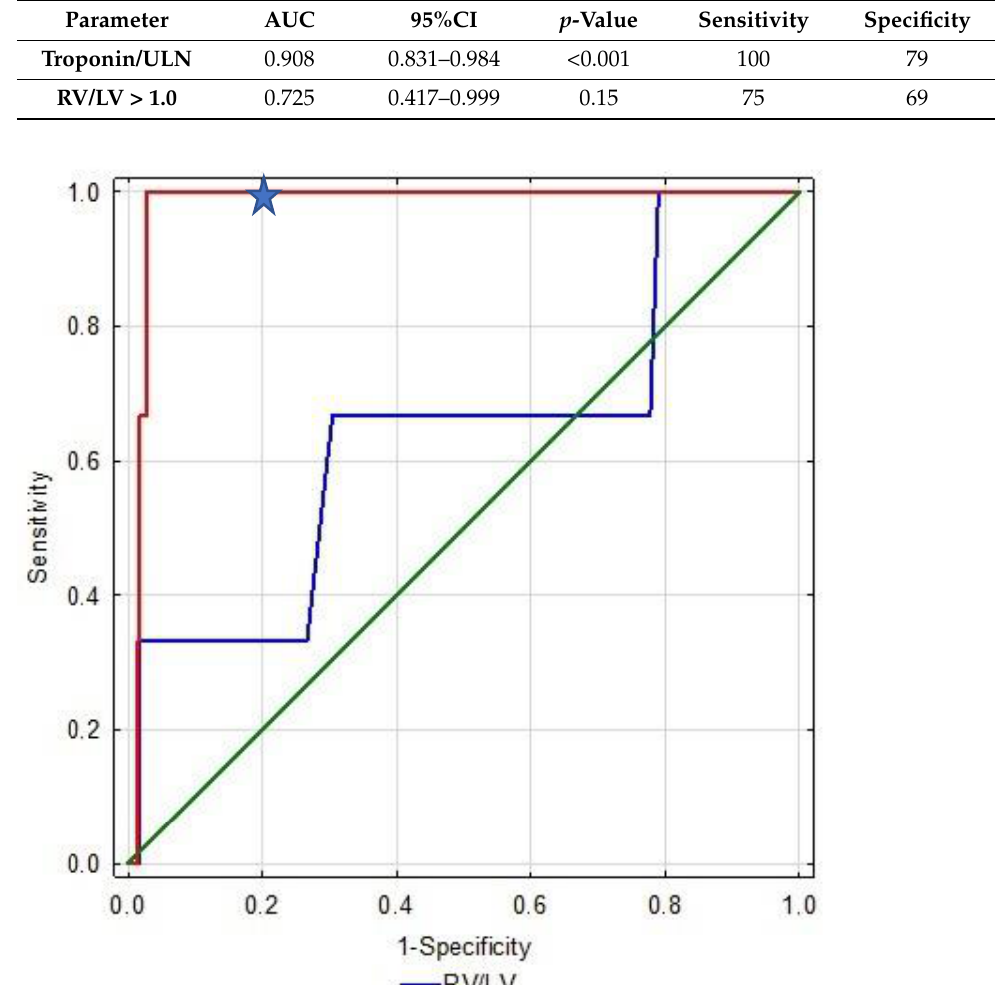
Table 3. Univariable predictors of SAE in sPESI 0 points APE patients.